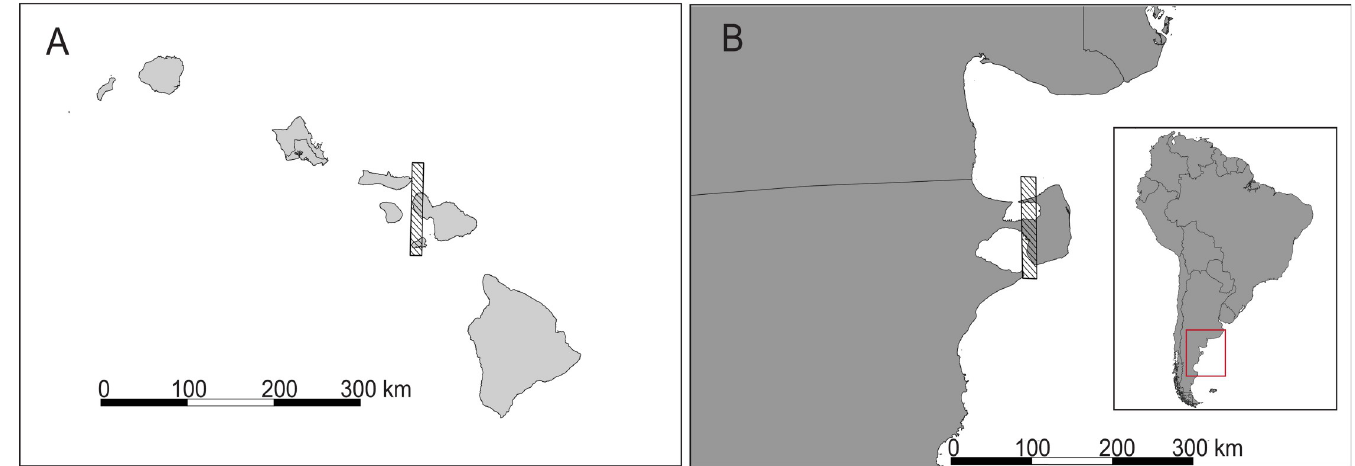
Fig 2. Locations of satellite imagery used. Maui, Hawaii (A) and Peninsula Valde´s, Argentina (B) [39].